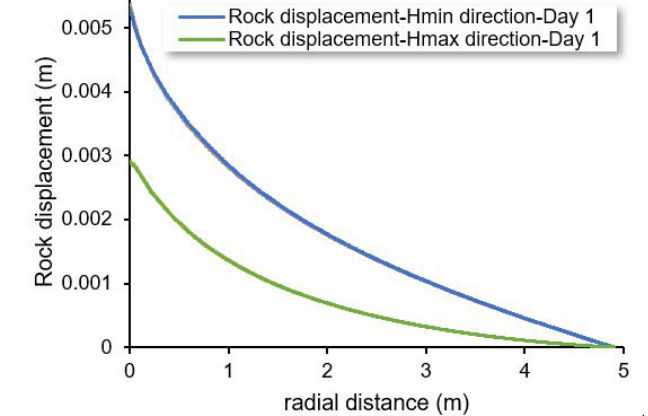
Figure 12. CSMP++ graphical plot of the rock displacement in the minimum and maximum horizontal in situ stress directions for the 2D poroelasticity transient